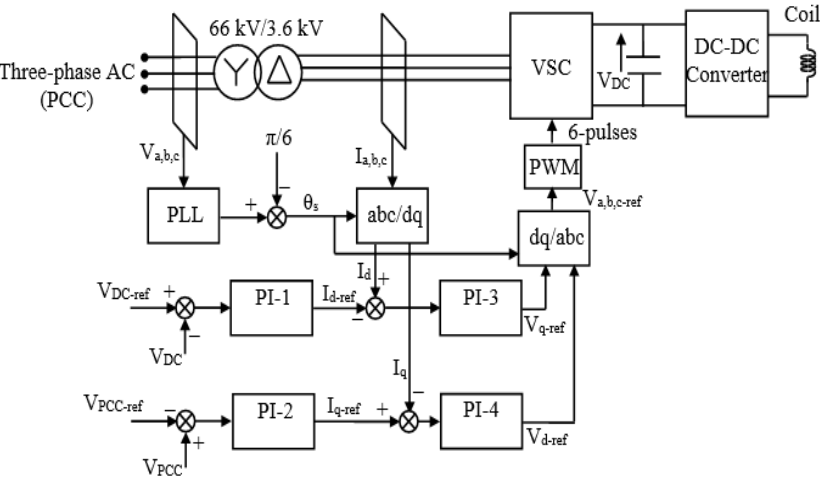
Figure 3. VSC control